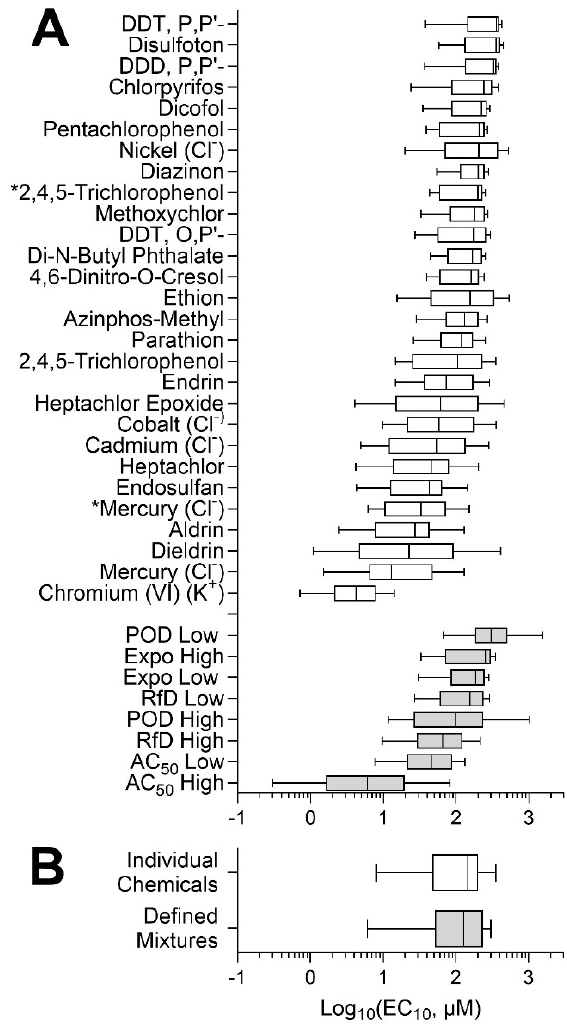
Figure 5. Concentration–response analysis of the inter-individual variability in chemical and mixture effects across all lymphoblast cell lines. ( A ) Distribution of the PODs for individual chemical (white) and defined mixtures (grey) is shown as box (interquartile range)-and-whiskers (5th and 95th percentiles) plots. Asterisks (*) denote compounds that were technical on-plate replicates. ( B ) Overall distribution of PODs for chemicals and defined mixtures.